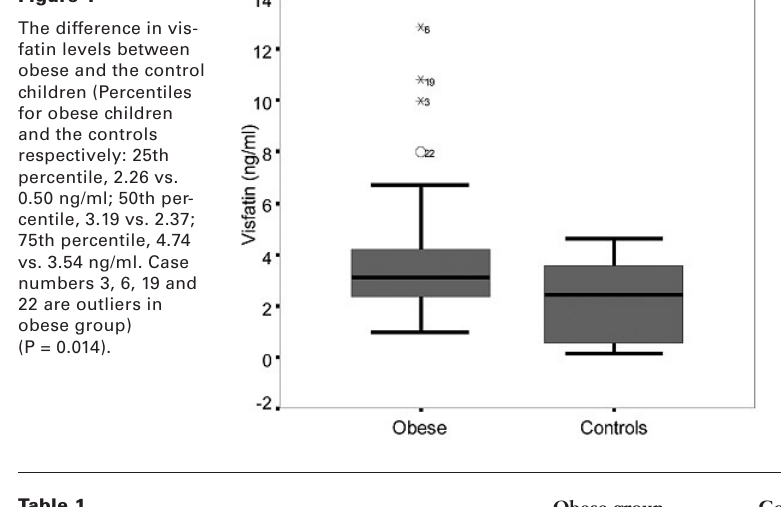
Anthropometric indices in obese and control children.